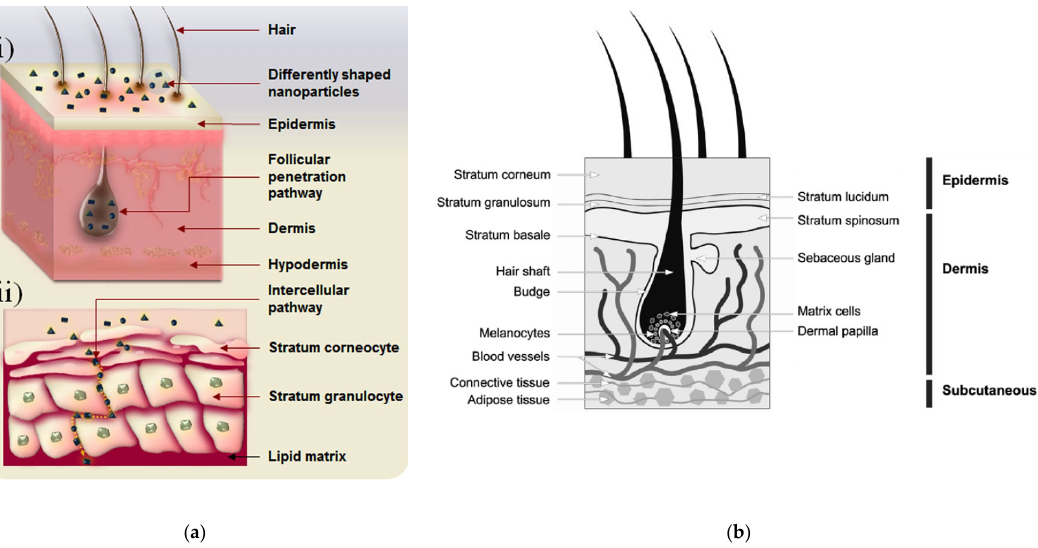
Figure 3. Schematic outline for the nanomaterial safety assessment in cosmetics based (but modified) on SCCS (Scientific Committee on Consumer Safety), Guidance on the Safety Assessment of Nanomaterials in Cosmetics, October 2019, SCCS/1611/19 [13].